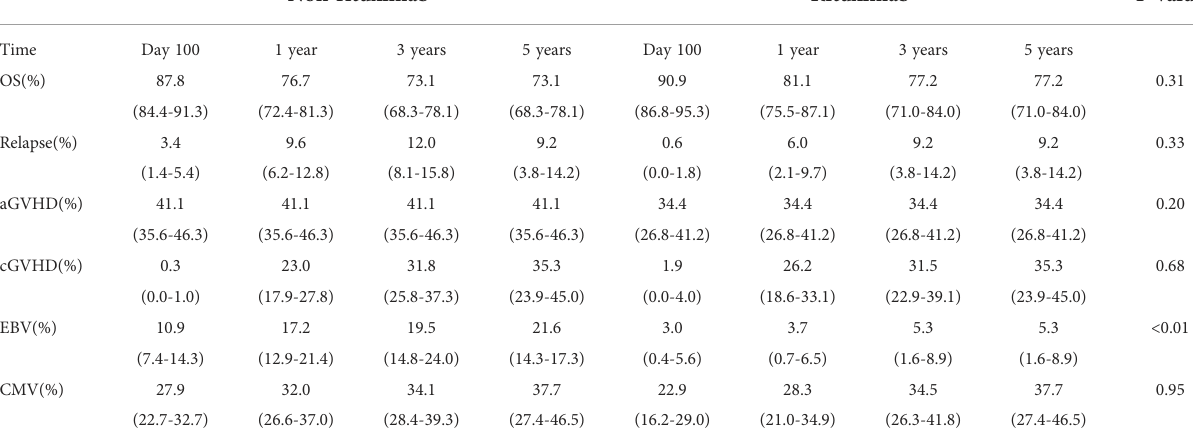
TABLE 2 Outcomes of the entire patient